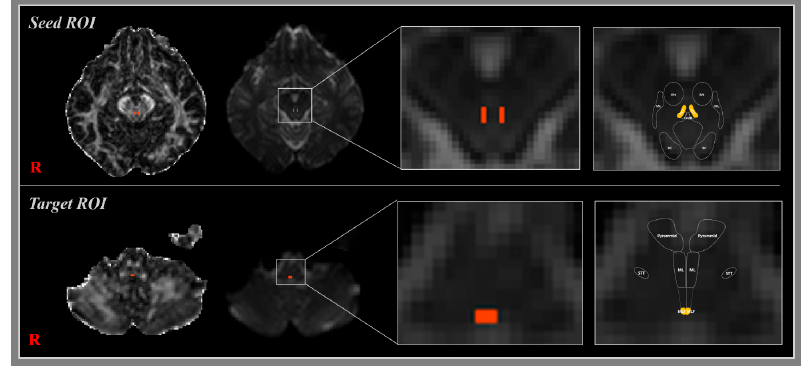
Figure 1. Seed region of interest (ROI) was placed in the interstitial nucleus of Cajal at the level of the midbrain. The target ROI was place on the medial longitudinal fasciculus (MLF) at the level of the medulla (orange